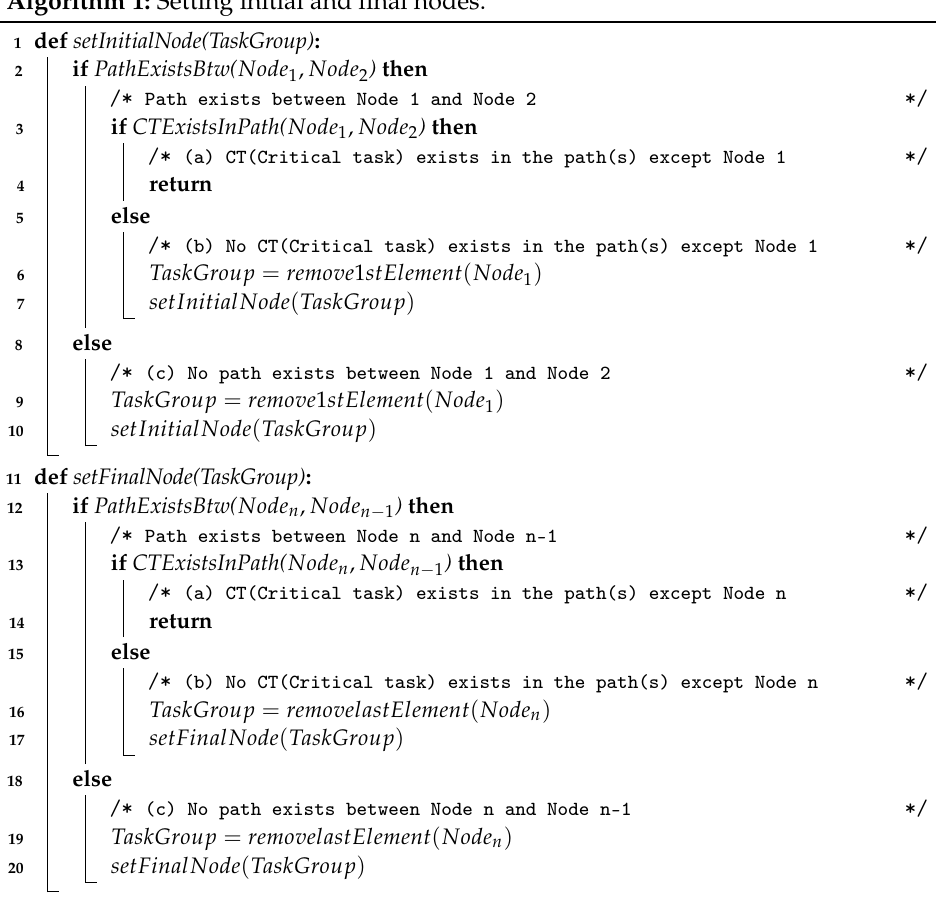
Figure 6. The flowchart for algorithm. Algorithm 1: Setting initial and final